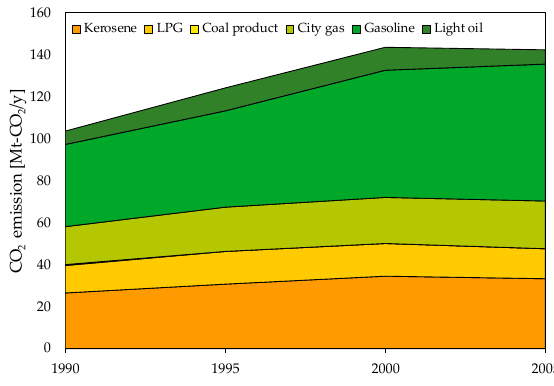
Figure 4. Trend in the direct CO 2 emissions by energy item.